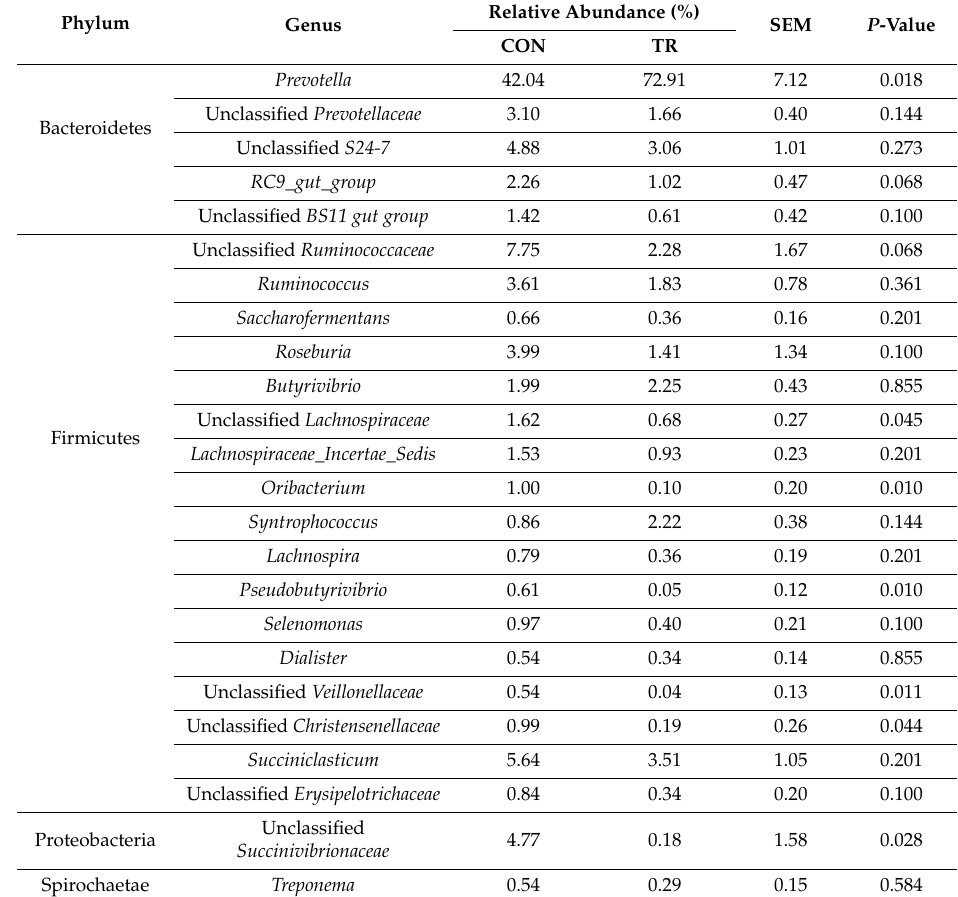
Table 6. The relative abundance of ruminal microbiome predominant genera 1 of CON 2 and TR 3